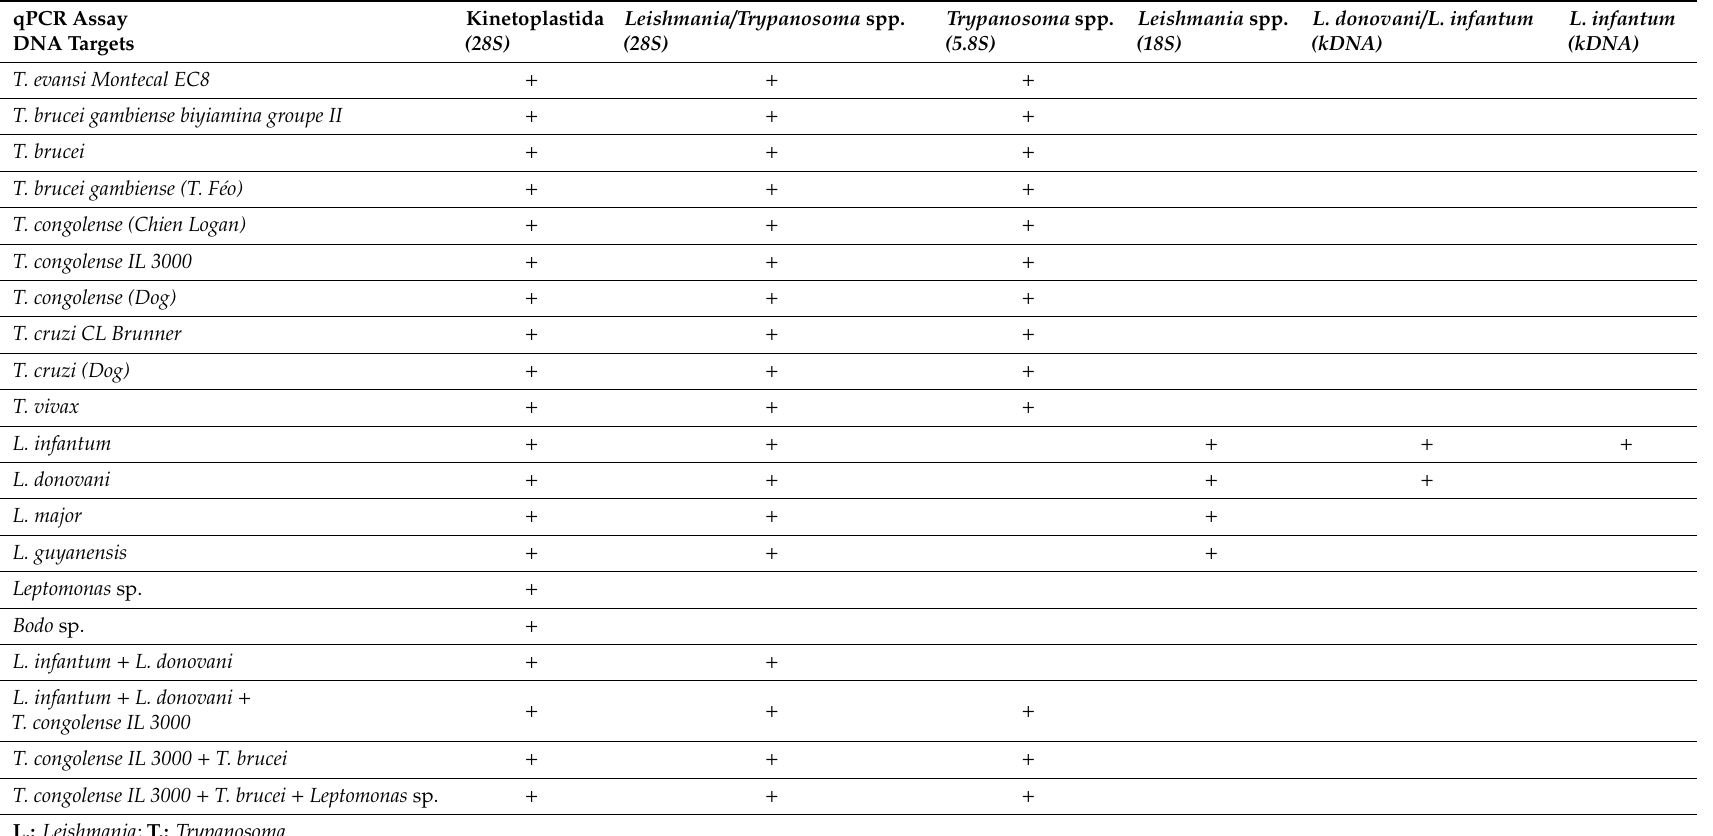
Table 2. In vitro validation relative specificity of the TaqMan qPCR assays.